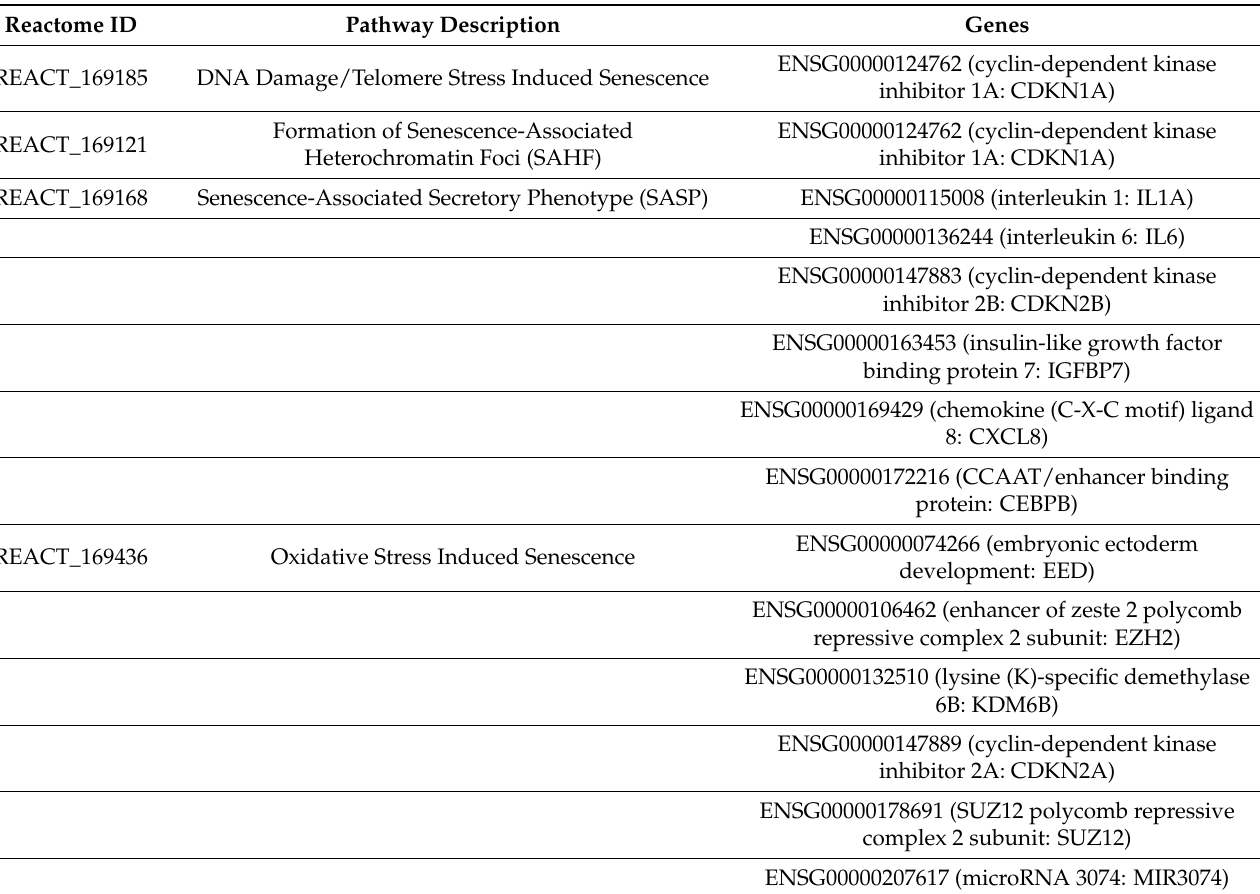
Table 2. Senescence linked pathways and miRNA targeting genes in